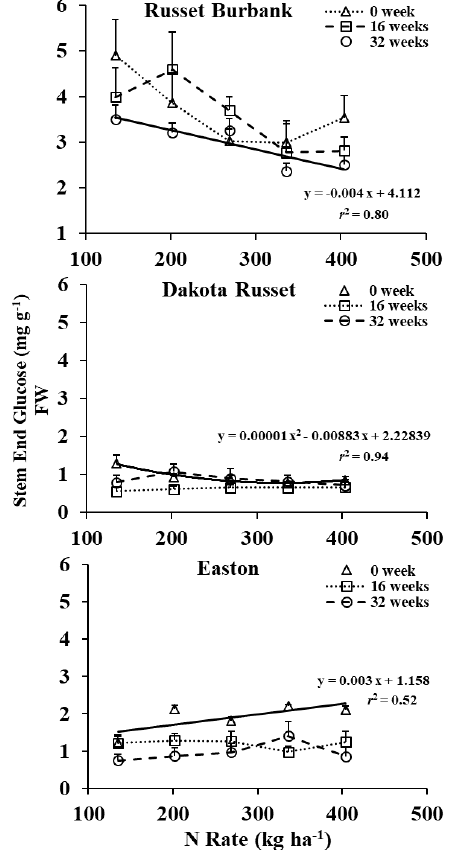
Figure 2. Three-way interaction of cultivar by N rate by storage time on stem-end glucose in 2014 and 2015.